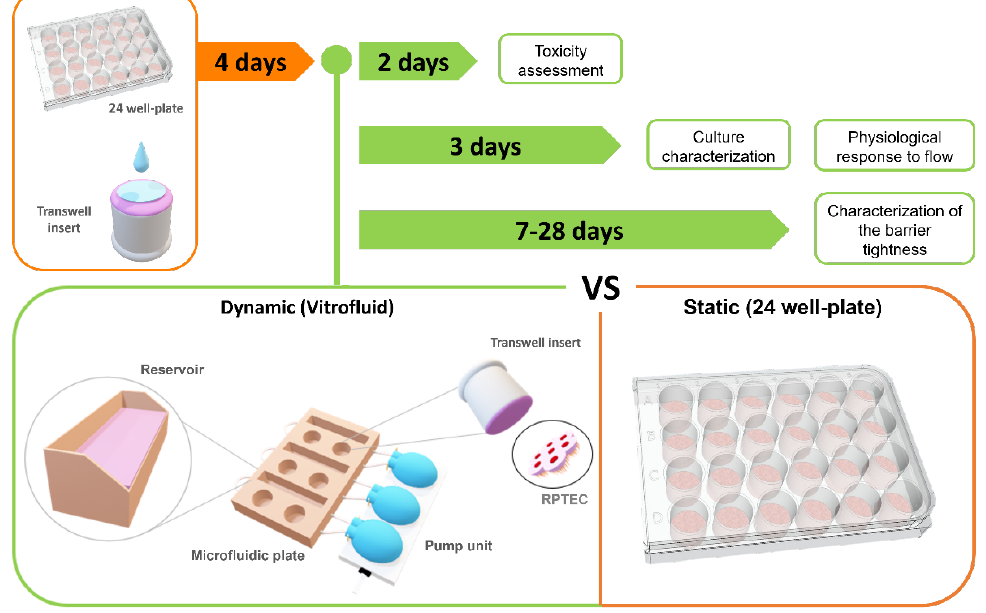
Figure 1. Overview and experimental timeline. RPTECs were cultured for 4 days under static conditions on the basal side of collagen-coated Transwell inserts (24 well-plates). Upon reaching confluence, some inserts were transferred to the Vitrofluid system to emulate a dynamic flow condition, and the remaining inserts were cultured in static conditions and used as controls. The responses to different doses of nephrotoxicants were evaluated on day two after administration. Characterization and the morphophysiological response of the cultures were studied on day three. Barrier tightness was characterized over 4 weeks.